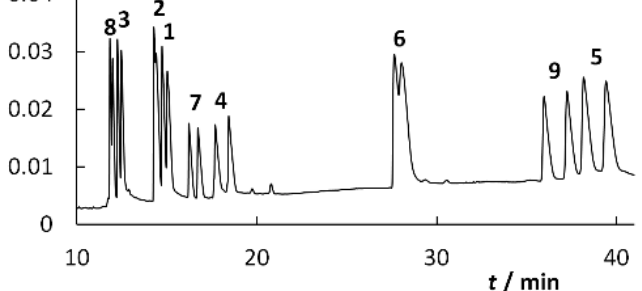
Figure 7. Electropherogram of the analyzed mixture of the studied analytes 1–9 (Figure 2) obtained; fused-silica capillary: od/id = 375/75 μ m, total/effective length: 58.5/50.0 cm; BGE: 50 mmol·L − 1 phosphate buffer, pH 2.75, 7.5 mmol·L − 1 CM- β -CD; voltage: 20 kV; temperature: 25 °C.